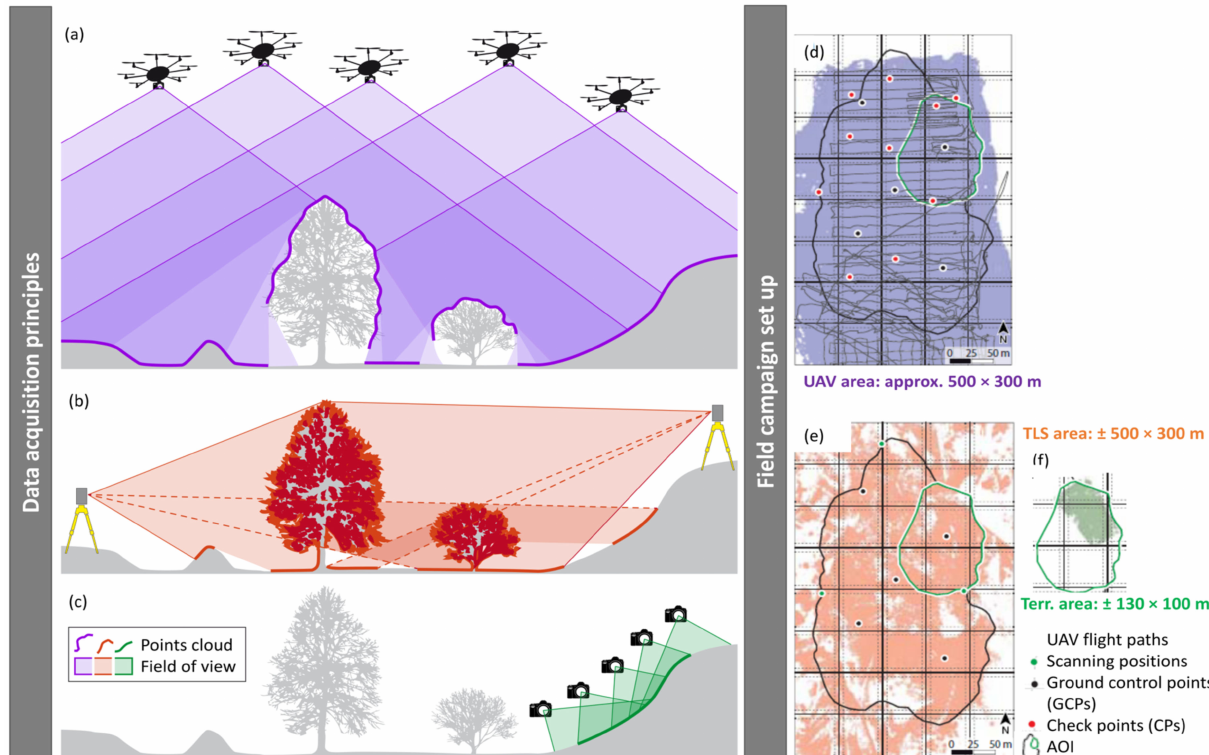
Figure 3. Data acquisition principles of the considered platforms/sensors as well as field set-up modes for UAV ( a , d ), Laser Scanner ( b , e ) and Terrestrial Photogrammetry ( c , f ). Example from the Corvara landslide (adopted with permission from ref.